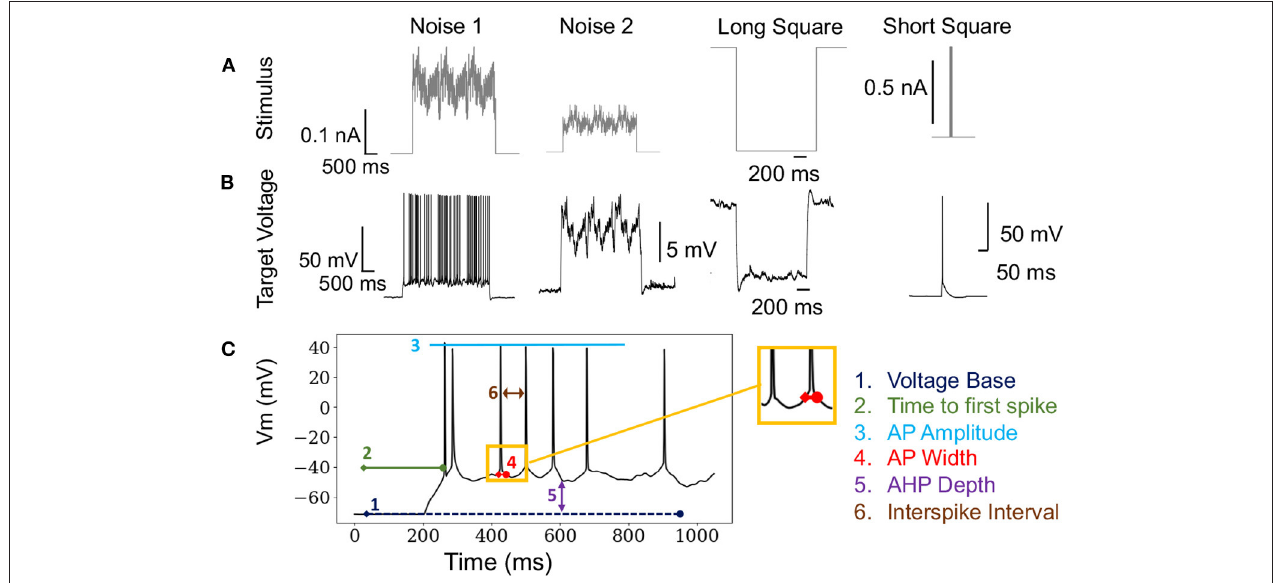
FIGURE 1 | Stimuli and electrophysiological score functions used in algorithm: (A) Various stimuli used in the fitting procedure of EA. (B) Corresponding target voltages that are recorded from patch clamp experiments as a result of the stimuli in (A) . (C) Demonstrates how electrophysiological score functions are computed on a single trace. These score functions are used to compare target and simulated firing traces.